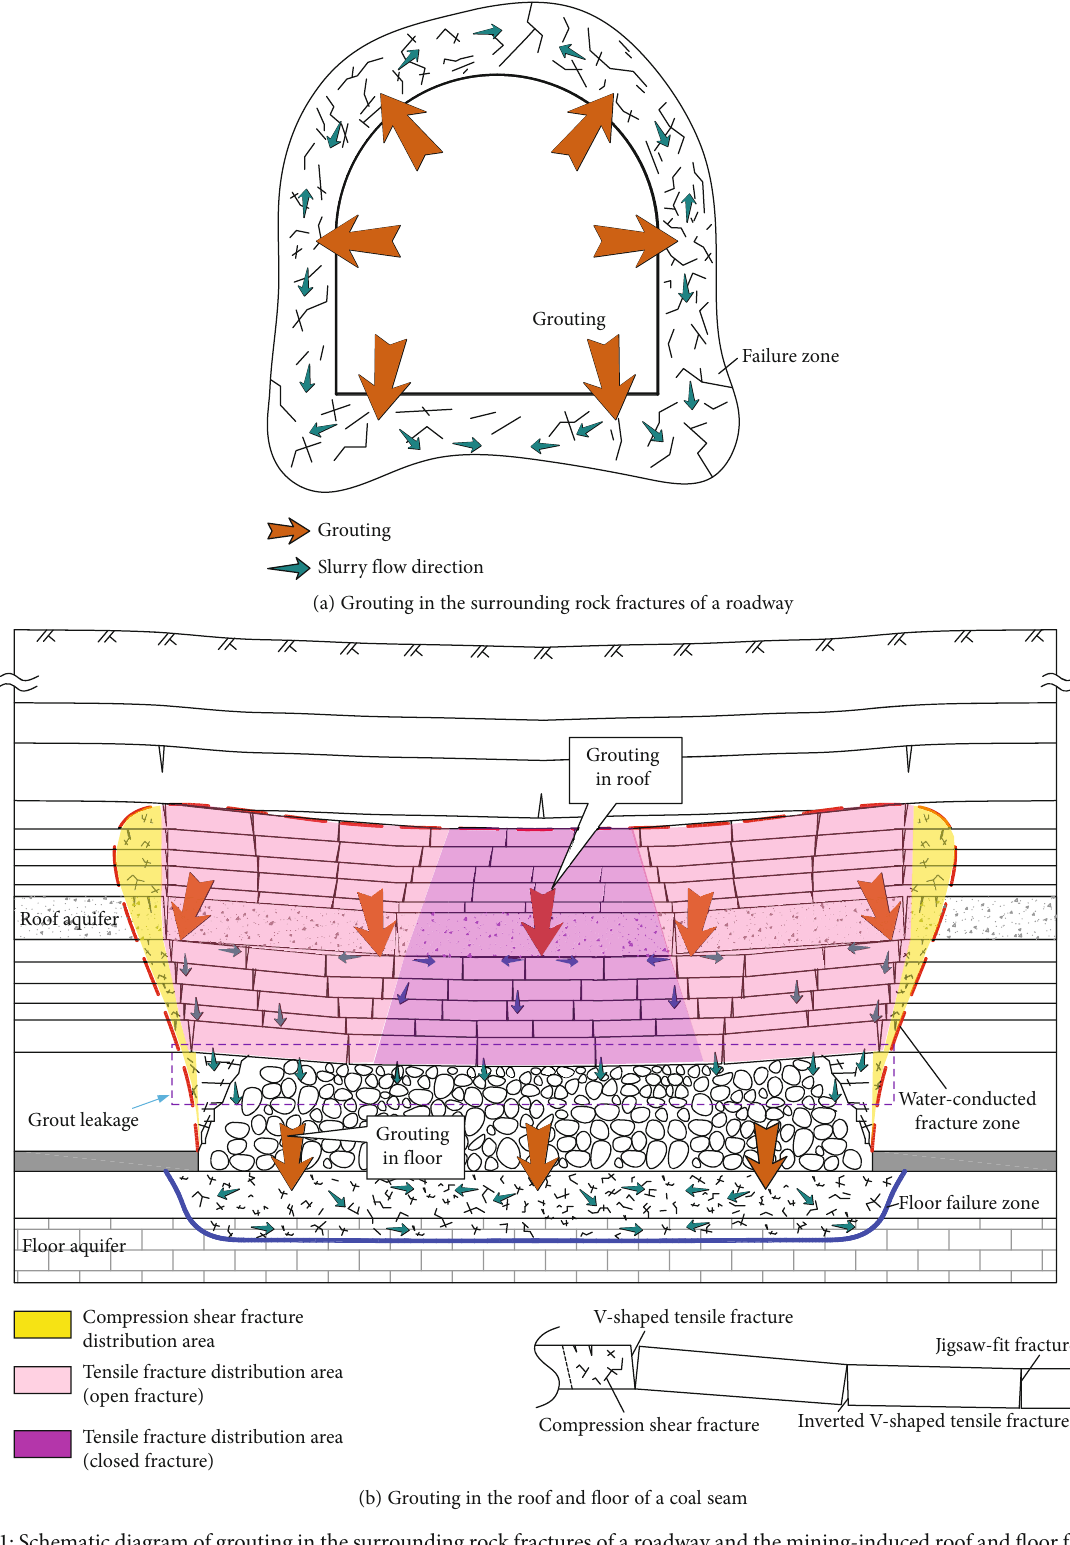
Figure 1: Schematic diagram of grouting in the surrounding rock fractures of a roadway and the mining-induced roof and fl oor fractures of a coal